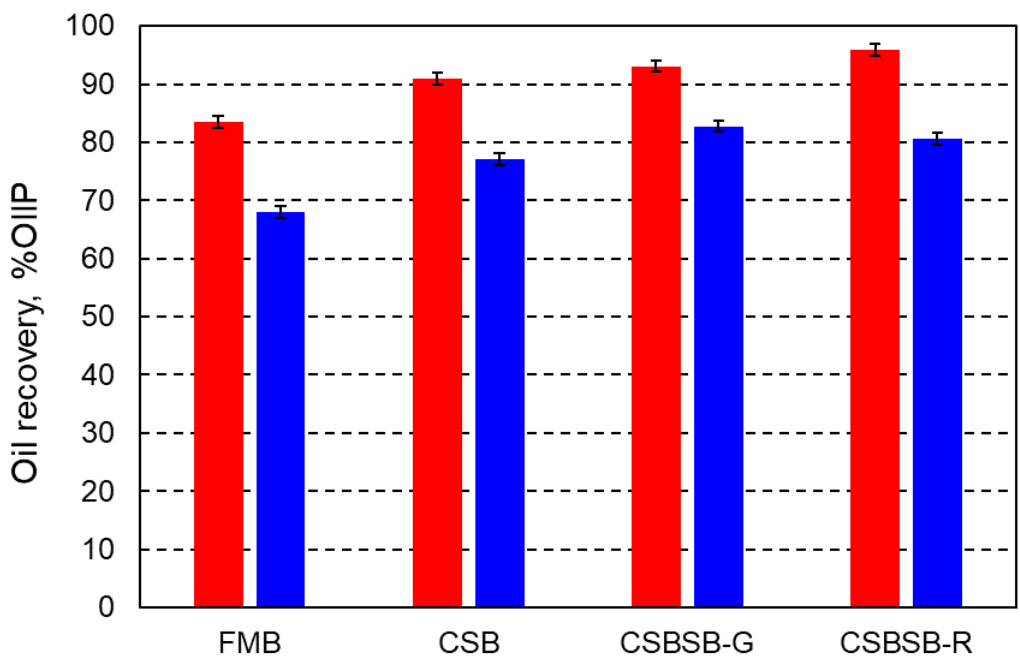
Figure 6. The ultimate oil recovery obtained with secondary injection of FMB, CSB and CSBSB-G and CSBSB-R. The red columns in the figure correspond to experiments conducted at 70 °C while the blue columns correspond to 23 °C experiments. The error bars represent the inaccuracy of measured produced volumes.